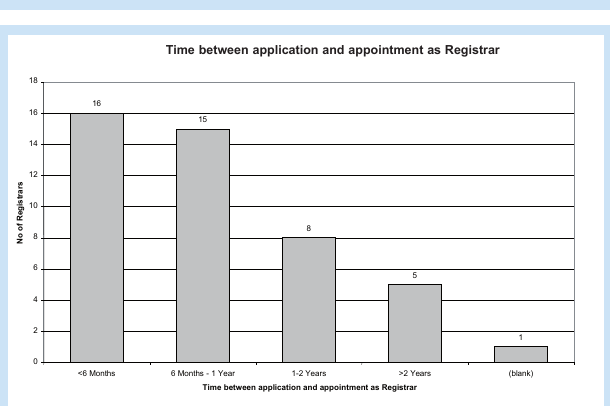
Fig. 6. Time between application and appointment as a registrar . Fig.6.Timebetweenapplicationandappointmentasaregistrar.